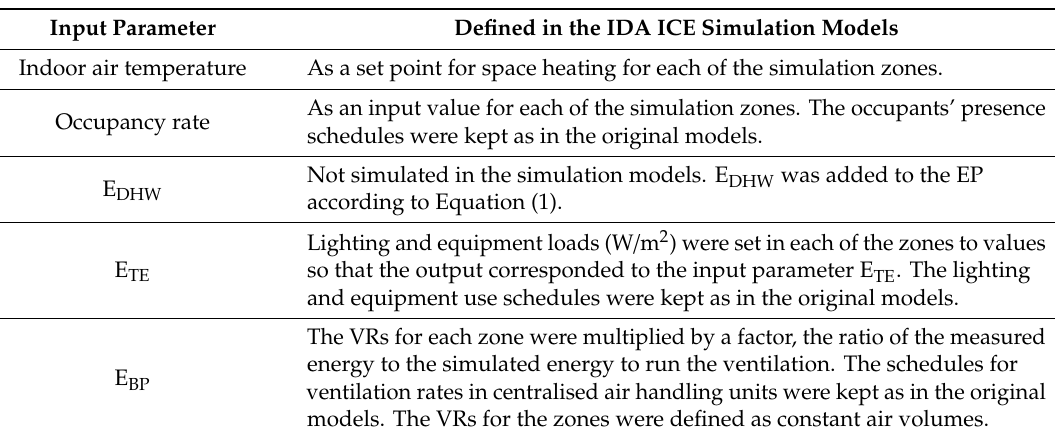
Table 4. How the input parameters from Table 3 were defined in the IDA ICE simulation